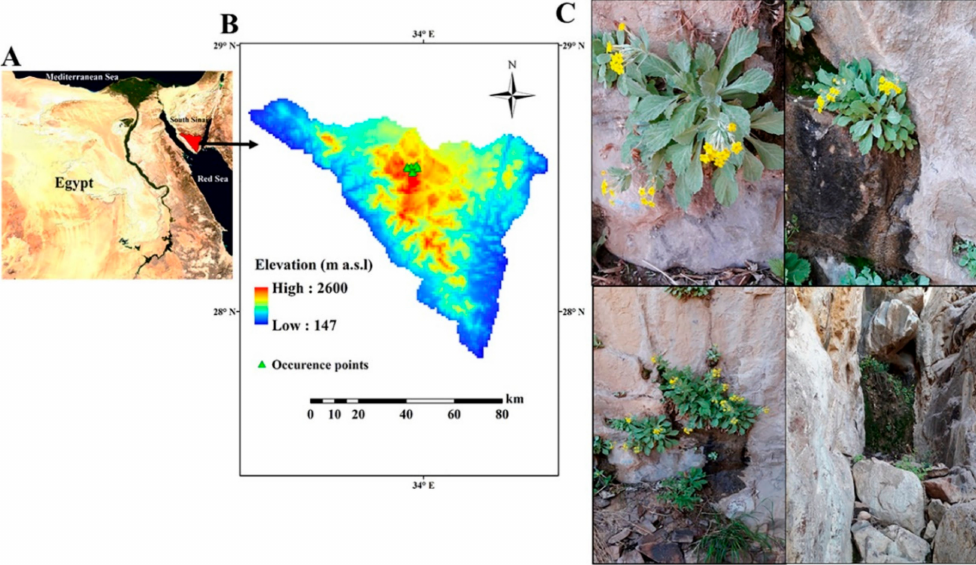
Figure 5. ( A ) Map of Egypt showing the location of St. Catherine Protectorate (red shaded) inside the Sinaic biogeographic subsector. ( B ) Current occurrence points of Primula boveana and ( C ) habitat of Primula boveana